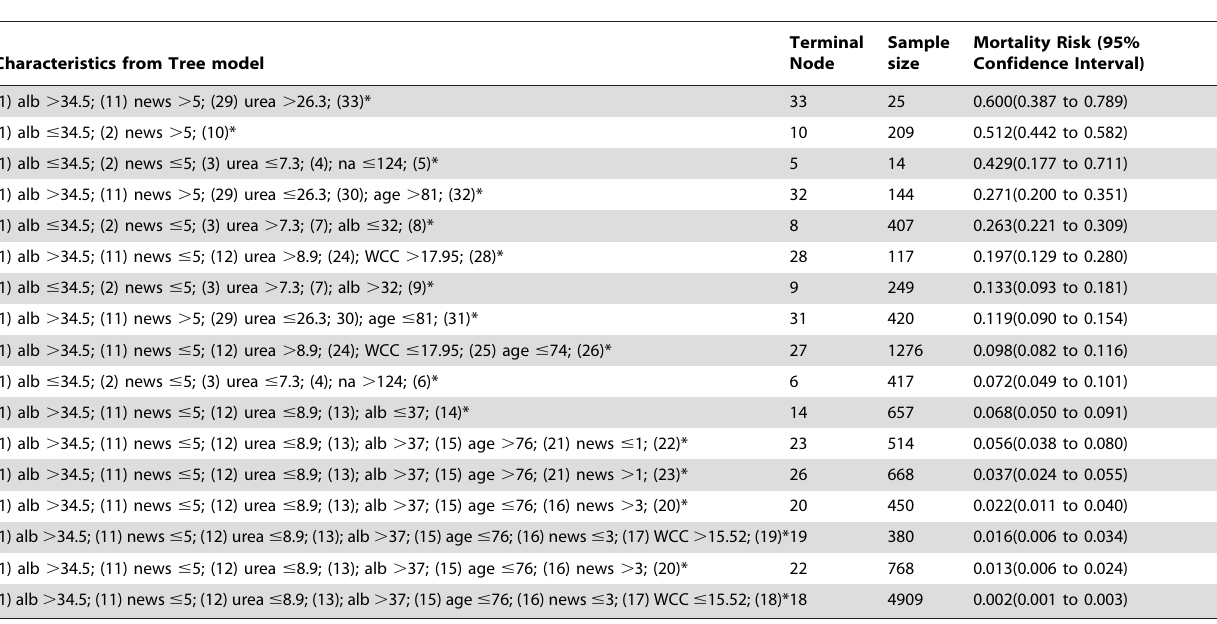
Table 2. Shows the characteristics of admission in the seventeen terminal nodes (in descending risk) of the Tree model.